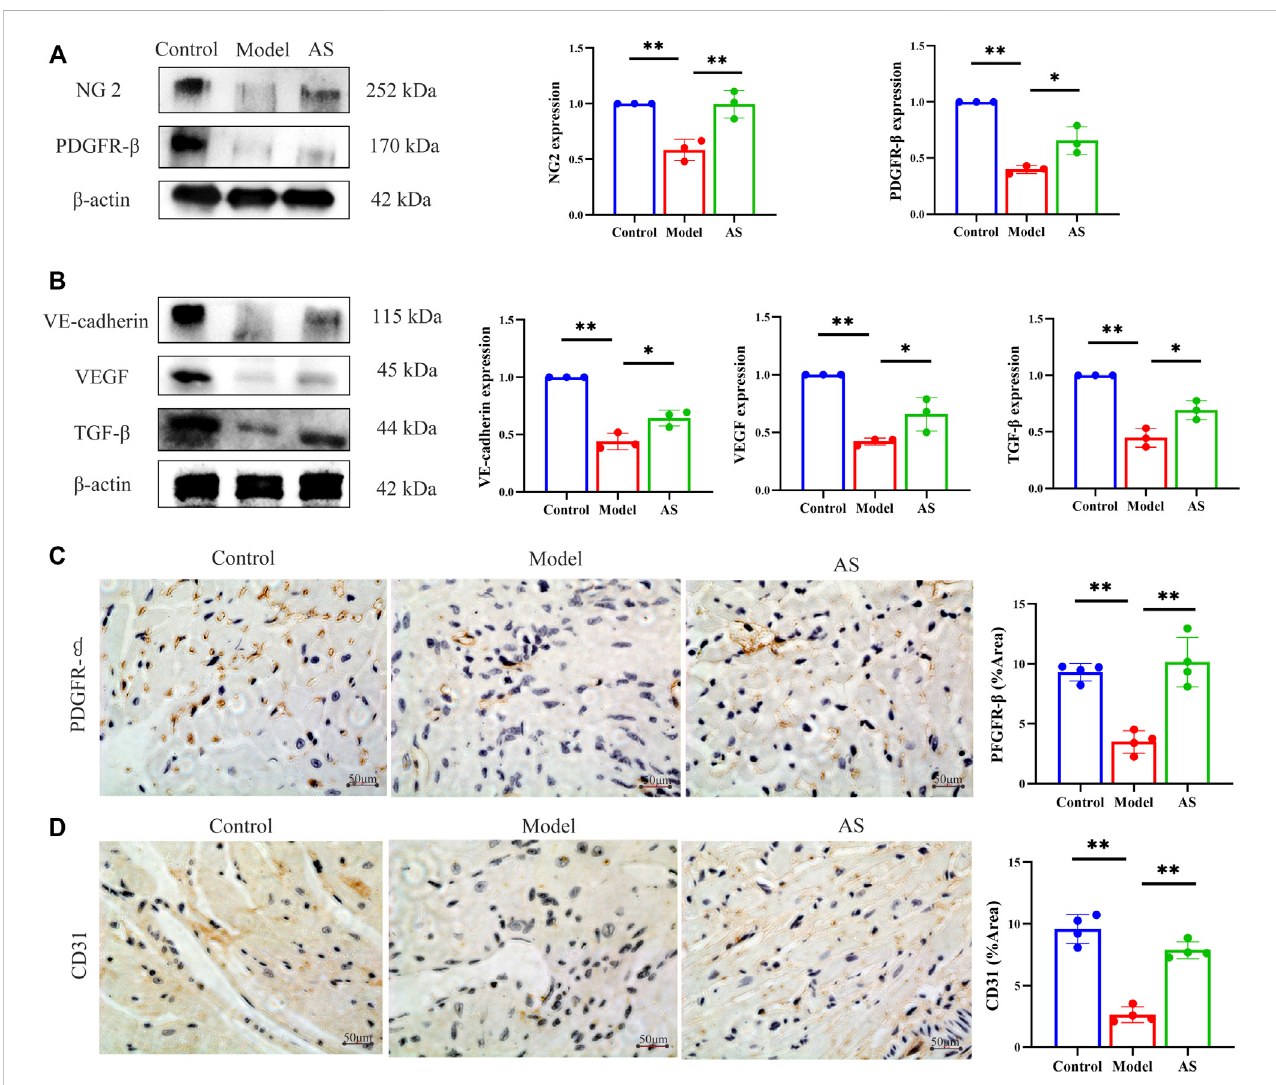
FIGURE 3 ASactivatespericyte recruitmentandpromotesangiogenesisinMImice. (A) Protein level ofNG2and PDGFR- β , resultsareexpressed asmean ±SD,n= 3, ** p < .01, * p < .05. (B) Protein level of VE-cadherin, VEGF and TGF- β , results are expressed as mean ± SD, n = 3, ** p < .01, * p < .05. (C) IHC staining, the brownish-yellow region is PDGFR- β , results are expressed as mean ± SD, n = 4, ** p < .01. (D) IHC staining, the brownish-yellow region is CD31, results are expressed as mean ± SD, n = 4, ** p <